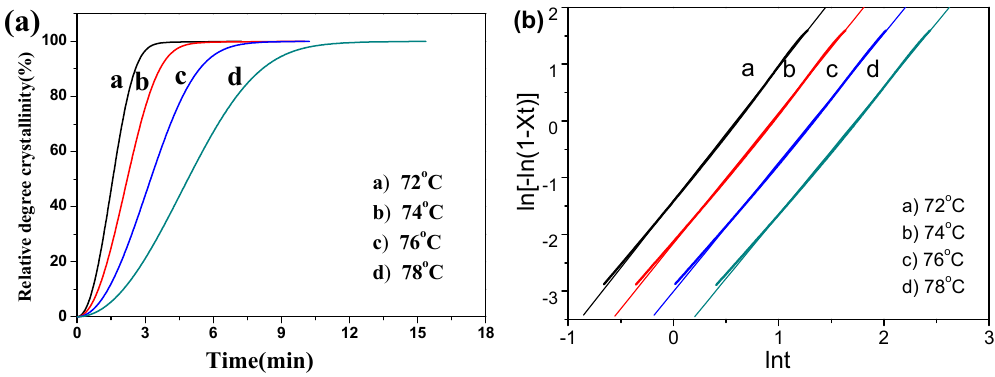
Figure 6. ( a ) Relative degree of crystallinity with time and ( b ) the Avrami plots of ln[ − ln(1 − X t )] versus ln t for isothermal crystallization of PBS/MBF (95/5) at different crystallized temperatures.